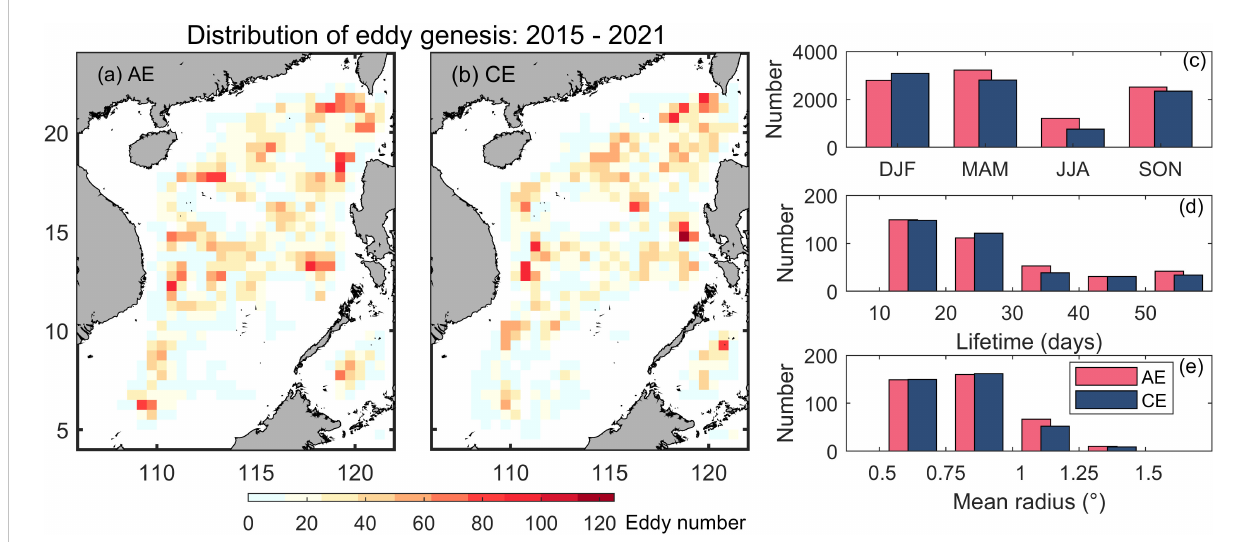
FIGURE 2 The distribution of (A) AEs and (red) (B) CEs (blue) in the SCS. The shaded area indicates the eddy number. The bar charts show the (C) seasonal distribution of eddies in the whole SCS (eddies are counted at each time step), distribution of (D) lifetime (unit: days) and (E) mean radius (unit: °) of eddies with full